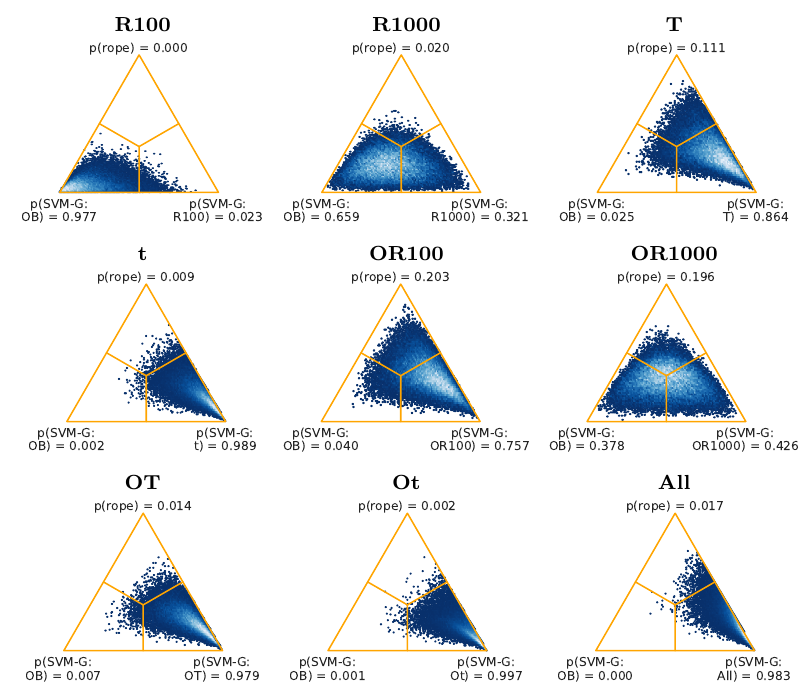
Figure 12. Posteriors for the Bayesian sign-rank tests for SVM-G, from the difficult